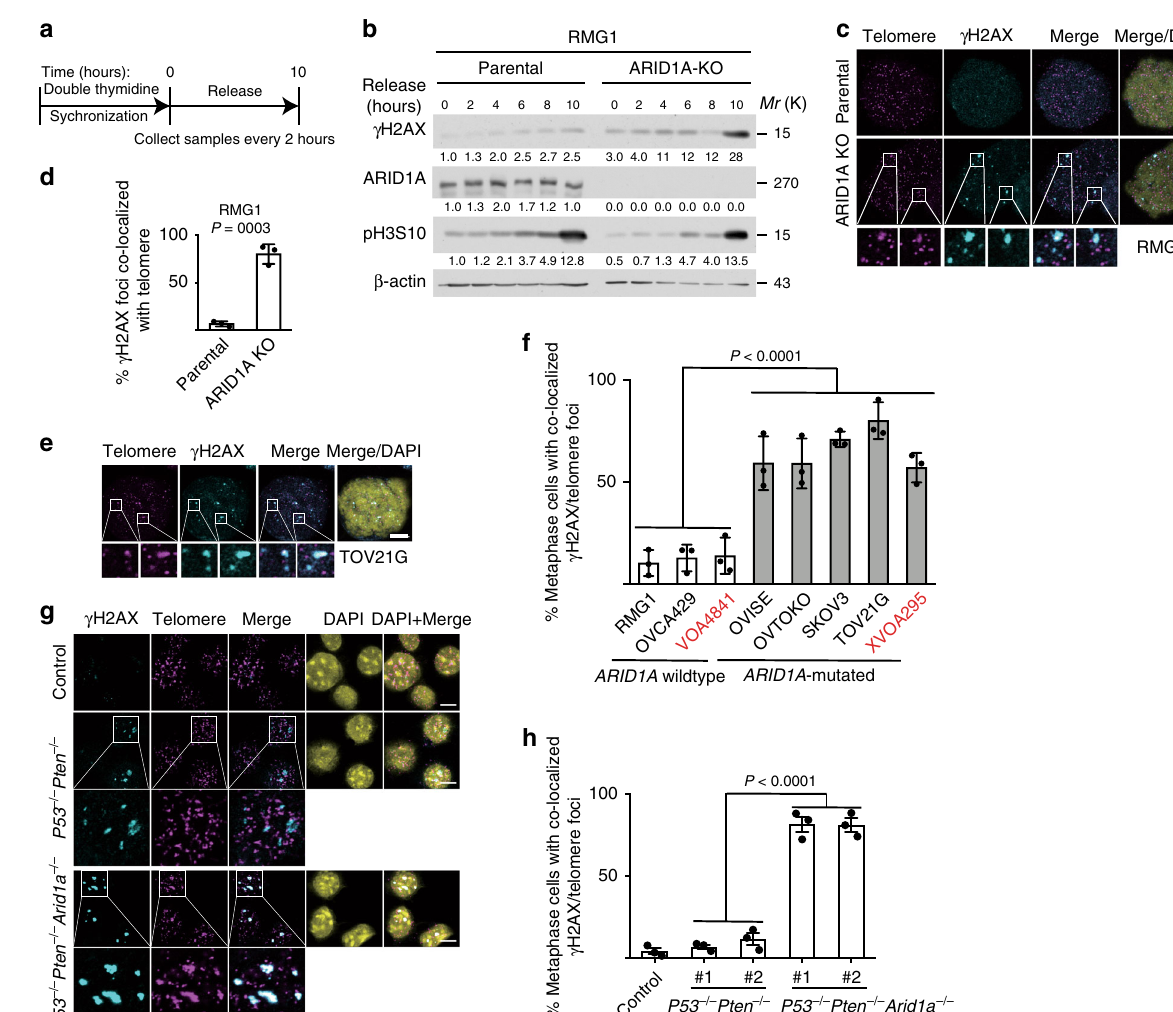
Fig. 2 ARID1A inactivation causes DNA damage at telomeres. a , b Schematic of synchronization and release ( a ) and immunoblot of DNA damage marker γ H2AX ( b ) in parental and ARID1A knockout RMG1 cells. Phosphorylated Histone H3 at serine 10 (pH3S10) was used as a marker of mitosis. Relative intensities of immunoblot bands were quanti fi ed underneath. c , d Co-staining of telomere by FISH and γ H2AX ( c ) and quanti fi cation of telomeric DNA damage ( d ) in mitotic parental and ARID1A knockout RMG1 cells after cytospin. e , f Co-staining of telomere by FISH and γ H2AX in ARID1A -mutated TOV21G mitotic cells ( e ) and quanti fi cation of mitotic telomeric DNA damage in a panel of clear cell ovarian cancer cell lines or primary cultures highlighted in red ( f ). g , h Representative images ( g ) and quanti fi cation ( h ) of telomere DNA damage in parental, P53 − / − / Pten − / − and P53 − / − / Pten − / − / Arid1a − / − mouse bladder organoid cultures. n = 3 independent experiments unless otherwise stated. Data represent mean± s.e.m. Scale bar = 10 μ m. P values were calculated using a two-tailed t test except in 2f and 2h by multilevel mixed-effects